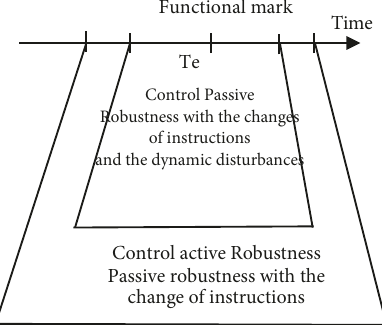
Figure 9: Active and passive